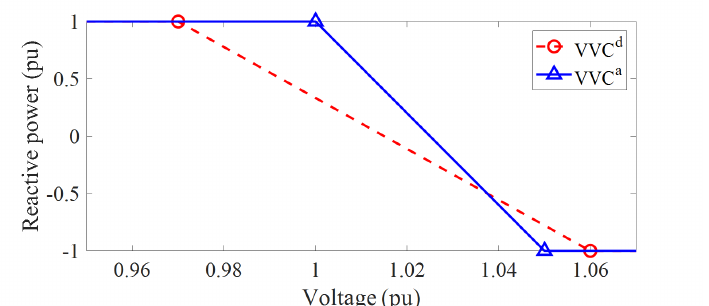
Figure 7. Volt-var curves determined in a case study. That for an aggregated bus VVC a is steeper than the default one VVC d . Similar trends are observed in the other